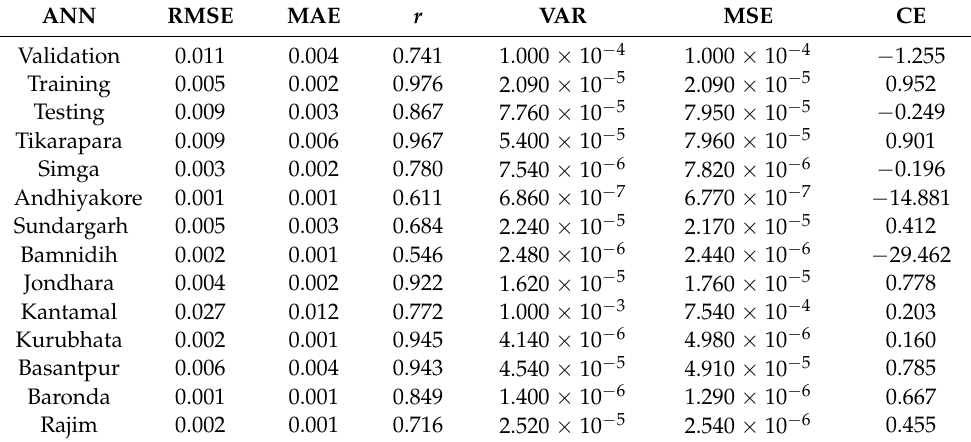
Table 4. Error statistics during the testing, training, and validation phases of the ANN model of 11 gauge stations of the